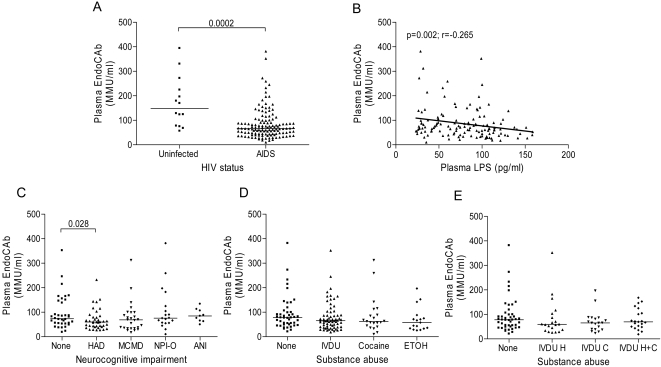
Decreased plasma IgM endotoxin core antibody (EndoCAb) levels in AIDS patients with HAD.(A) Levels of IgM EndoCAb were quantified in plasma from AIDS patients (n = 119) and uninfected controls (n = 14) by ELISA. (B) Spearman correlation (r and p-values) was calculated to determine relationships between IgM EndoCAb levels and plasma LPS. (C) IgM EndoCAb levels were compared between AIDS patients classified into 5 groups based on the level of NCI as in Figure 1C or (D–E) classified into groups based on patterns of substance abuse as in Figure 2A–B. Median values are indicated as horizontal lines and statistical significance between groups was calculated using the Mann-Whitney test; significant differences (p<0.05) are indicated.